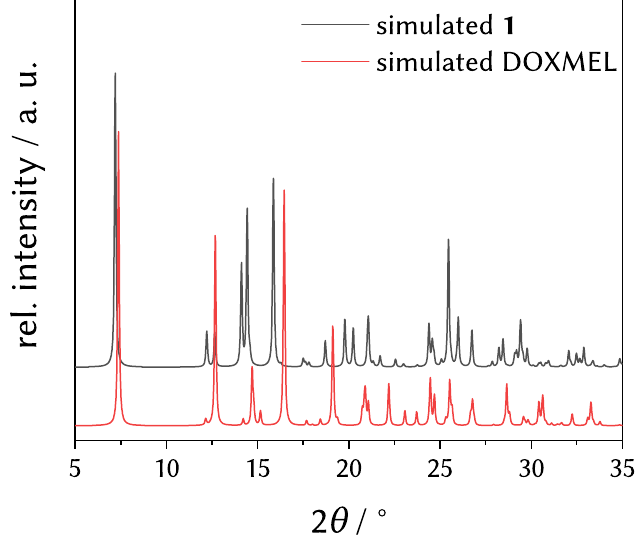
Figure 7. Simulated powder X-ray diffractograms of 1 (black) and DOXMEL (red) in comparison.